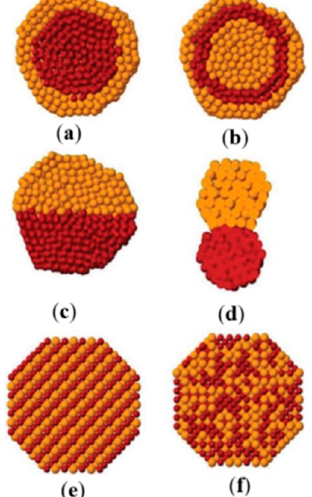
Figure 1. Possible morphologies of bimetallic nanoparticles (one metal in red, the other in dark yellow): ( a , b ) core–shell system; ( c ) multishell system; ( d ) subcluster segregated systems; and ordered ( e ) and random ( f ) homogeneous alloys. Reprinted (adapted) from [58], Copyright 2008, American Chemical Society.